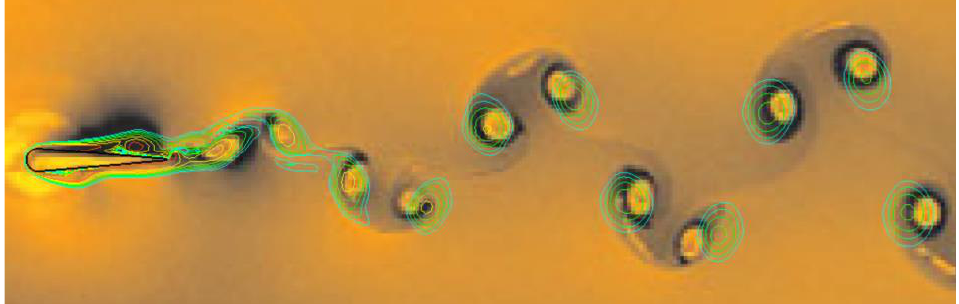
Figure 6. Comparison of the vorticity pattern visualized in the foil wake ( 𝑆𝑡 𝐷 = 0.08, 𝐴 𝐷 = 1.4 ). (Experimental results are from Figure 3c in Schnipper [18]).